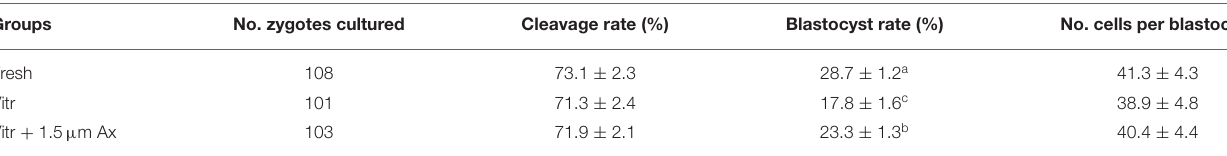
TABLE 2 | Effects of astaxanthin (Ax) supplementation (1.5 µ m) on developmental competence of vitrified zygotes derived from somatic cell nuclear transfer.